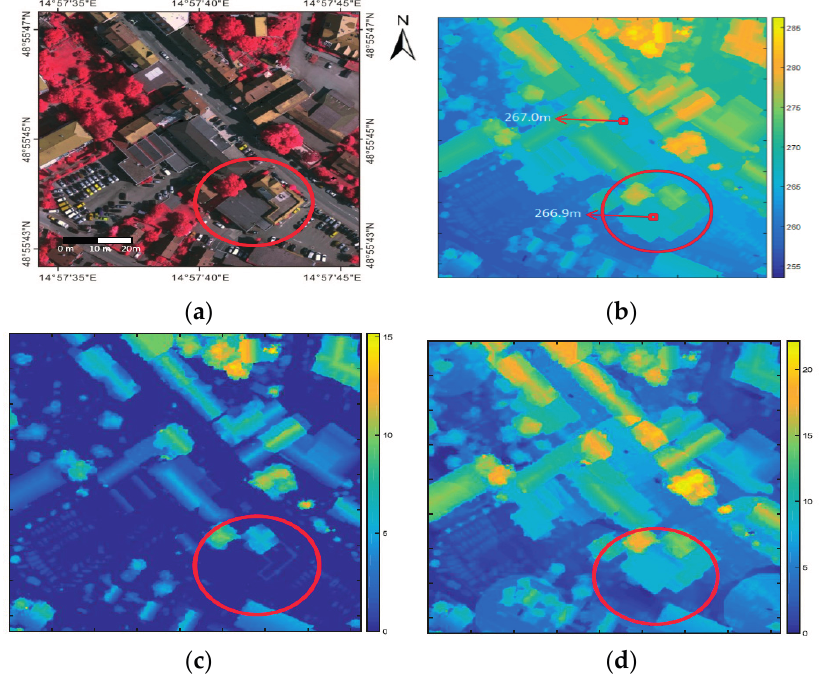
Figure 1. Results of top-hat by reconstruction (THR) and top-hat by erosion (THE) on a DSM of a test area (meters). ( a ) The orthophoto; ( b ) DSM; ( c ) THR; ( d ) THE. (The marked area is explained in the